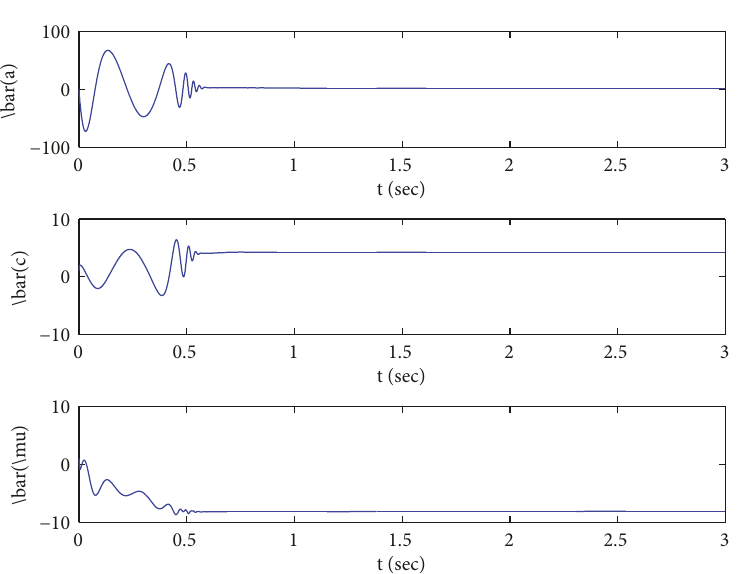
Figure 9: The time response of the error state 𝑒 3 .